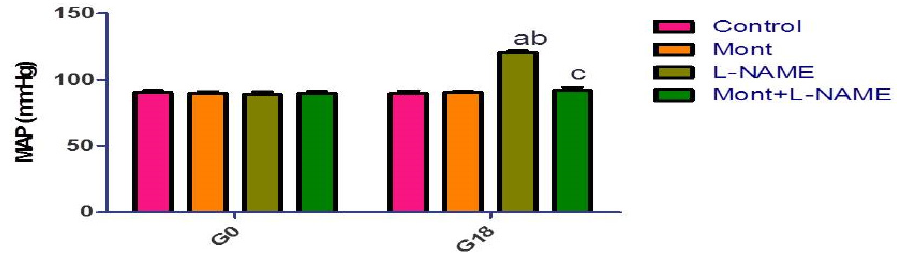
Figure 1. Effect of montelukast on blood pressure in a pre-eclampsia model in rats. rats/group). (a) Significant ( p < 0.05) difference from the control group. (b) Significant ( p < 0.05) difference from the Mont group. (c) Significant ( p < 0.05) difference from the L-NAME group. [Mont: montelukast; L-NAME: L-NG-Nitro arginine methyl ester].